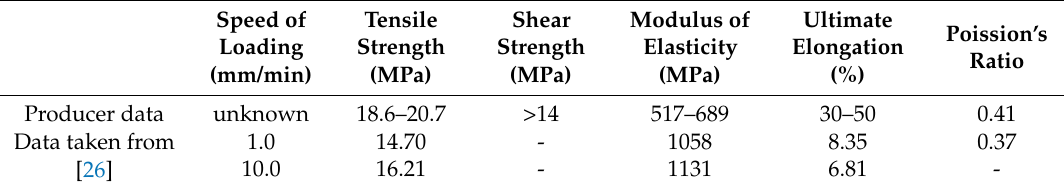
Table 3. The most important parameters of methacrylate adhesive